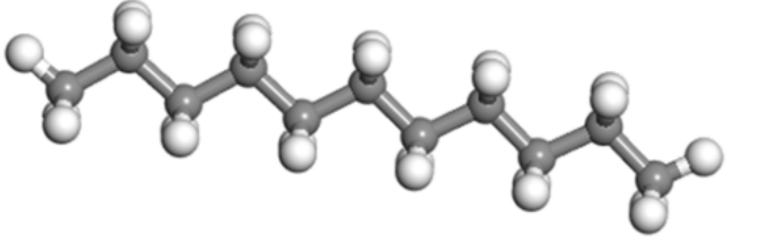
Figure 3. Wax molecular model.